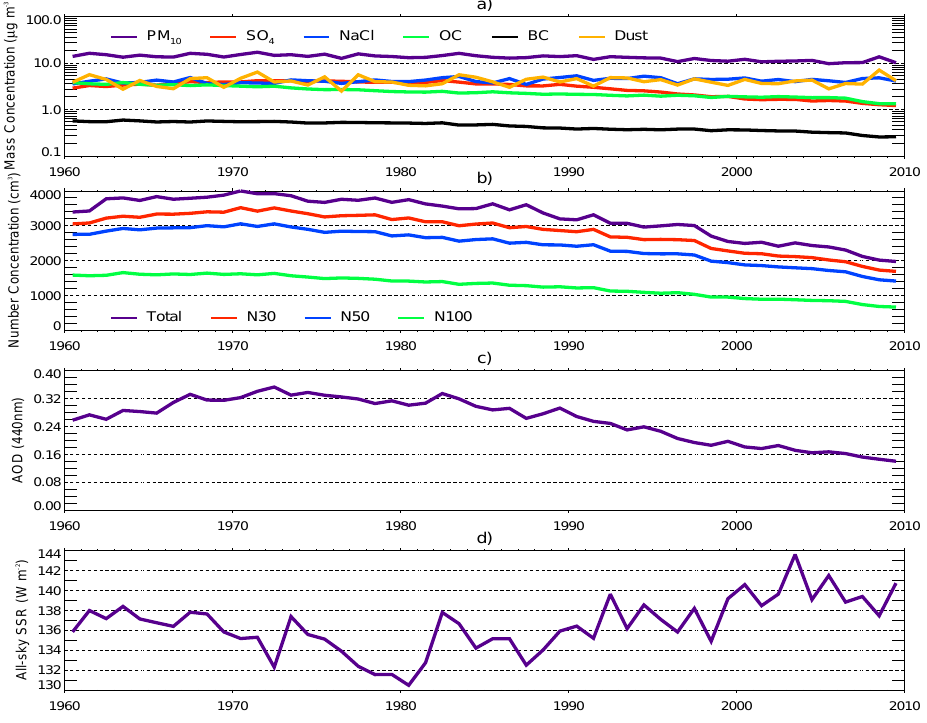
Figure 4. Simulated European annual mean (a) PM 10 and composition-resolved surface mass concentration; (b) aerosol number concentra- tion for particles with dry diameter > 3 (total), > 30 (N30), > 50 (N50) and > 100nm (N100); (c) AOD at 440nm; and (d) SSR between 1960 and 2009. Mean values are calculated over the European land domain shown in Fig. 1. Table 2. Statistical summary of modelled and observed annual and seasonal (DJF and JJA) mean sulfate at all long-term ( > 20 years data) measurement sites (34 sites) between 1978 and 2009. Absolute and relative (%) changes in concentrations are calculated as the difference between the mean of the initial 5 years of data minus the mean of the last 5 years of data. Trends that are above or below the value of twice of the standard error of the trend (95% confidence) are highlighted in